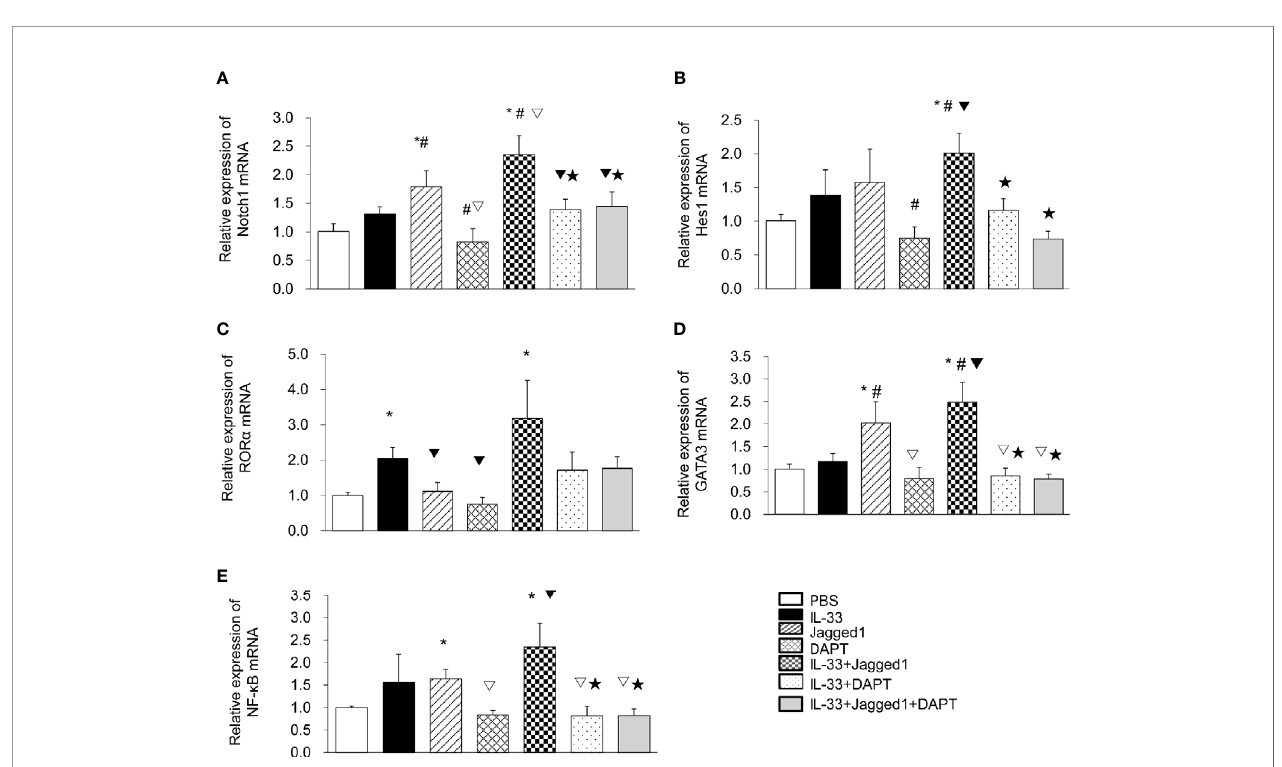
FIGURE 3 | The mRNA levels of Notch1 , Hes1 , ROR a , GATA3 and NF- k B in different groups. The relative levels of Notch1 (A) , Hes1 (B) , ROR a (C) , GATA3 (D) , and NF- k B (E) mRNA in the supernatant of PBS group, IL-33 stimulation group, Jagged 1 treatment group, DAPT treatment group, IL-33 + Jagged 1 treatment group, IL-33 + DAPT treatment group were determined by real-time PCR. Data are shown as mean ± SEM. n=10. * P < 0.05 compared with PBS group, # P < 0.05, compared with IL-33 group, ▽ P < 0.05 compared with Jagged1 group, ▼ P < 0.05 compared with DATP group, ★ P < 0.05 compared with IL-33+Jagged1